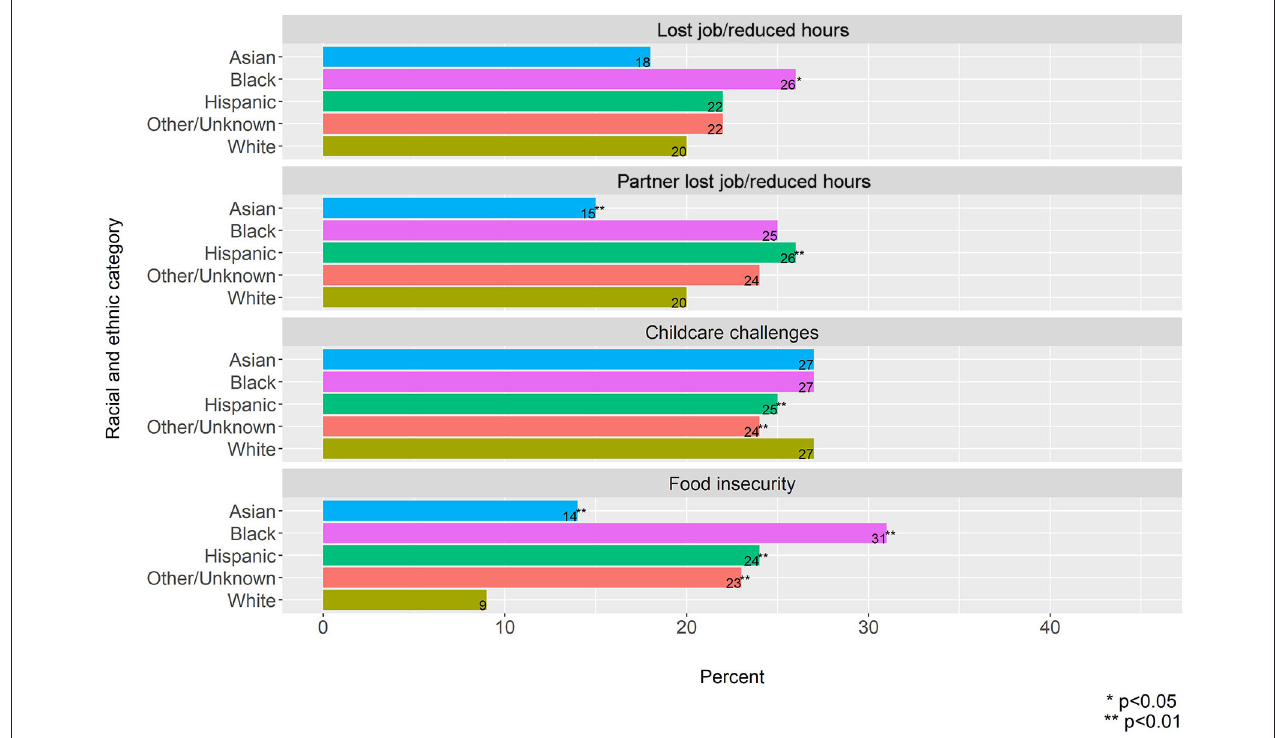
FIGURE 2 | Prevalence of economic stressors by racial and ethnic